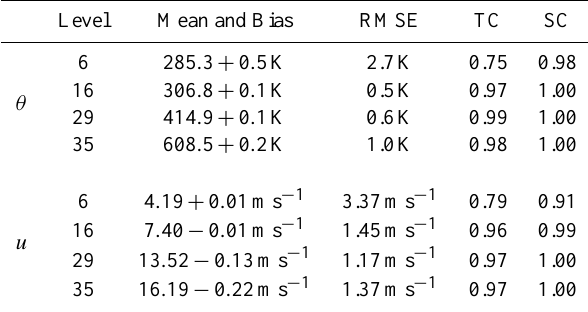
Table 1. Quantitative assessment of model performance in October 2005 with ERA-Interim nudging using the statistical assessments of Telford et al. (2008) for potential temperature ( θ ) and zonal wind ( u ). This calculates the model mean on four representative model levels and determines the root mean squared error (RMSE) and cor- relations over time (TC) and space (SC) with respect to the ERA- Interim analyses on these same